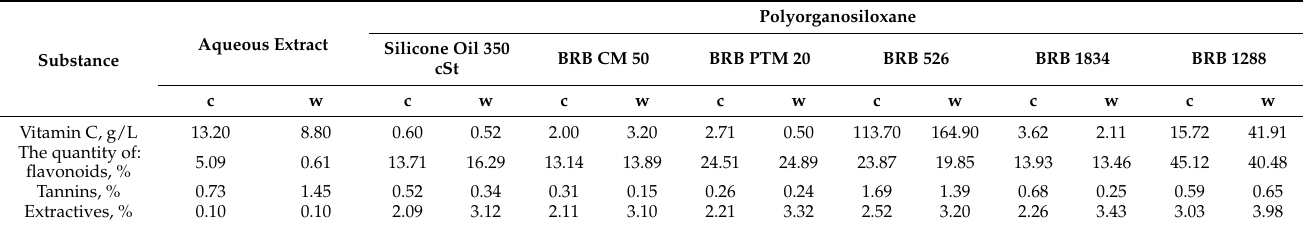
Table 4. Quantitative content of biologically active substances in silicone extracts of calendula (c) and wormwood (w).